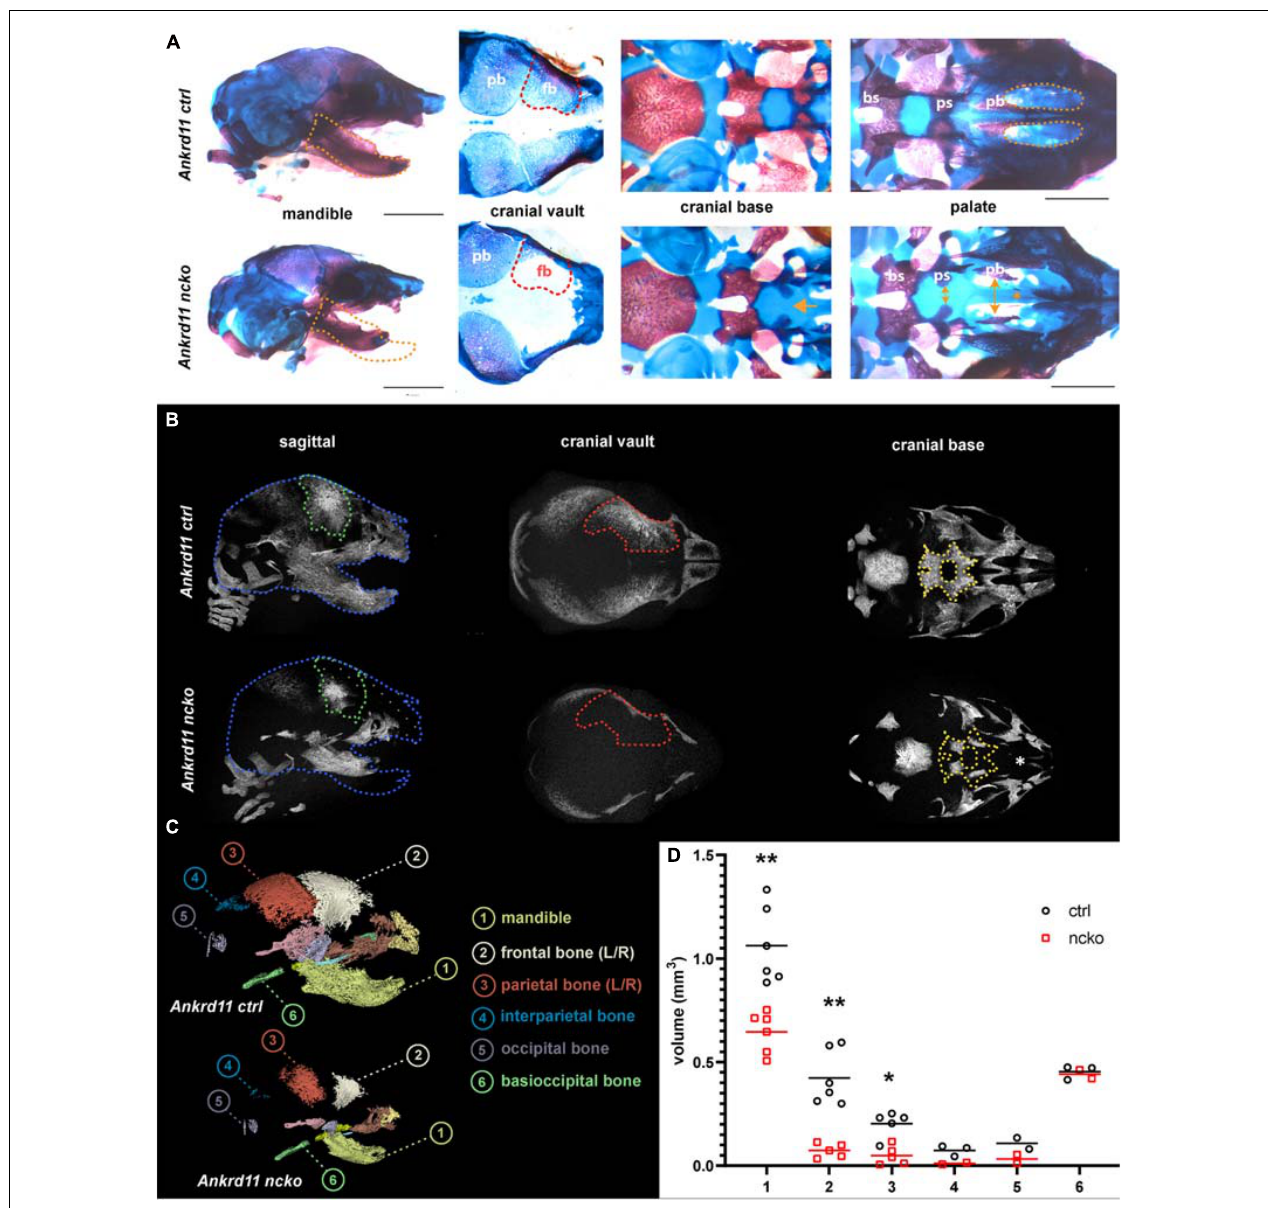
FIGURE 2 | Ankrd11 ncko mice have compromised ossification in craniofacial structures at birth. (A) Wholemount images of postnatal day 0 (P0) skull skeletal preparations, stained with Alizarin red and Alcian blue. Left panels: Orange dotted lines outline Ankrd11 ctrl (Ankrd11 fl / fl ) mandible to indicate micrognathia in the mutant. Middle left panels: Red dotted lines outline Ankrd11 ctrl (Ankrd11 fl / fl ) frontal bone to indicate its smaller size in the mutant. Middle right panels: Yellow arrows indicate extra space between presphenoid and palatine bones of the cranial base. Yellow asterisk to the right highlights clefting of hard palate in Ankrd11 ncko mouse. Right panels: magnified view of palate. bs, basisphenoid bone; ps, presphenoid bone; pb, palatine bone. Scale bar represents 2 mm, third column represents 1 mm. (B) µ CT scans of P0 Ankrd11 ncko and Ankrd11 ctrl skulls reconstructed in Amira. Blue dotted lines: Ankrd11 ctrl skull outline. Green dotted lines: control frontal bone outline. Tan dotted fill in Ankrd11 ncko : negative space between control mouse and mutant. Red dotted lines: control frontal bone outline. Yellow dotted lines: control basisphenoid and presphenoid hard tissue outline. White asterisk indicates reduction in palatine bone ossification in the mutant mouse. (C) representative segmentation of individual bones from µ CT scans of P0 Ankrd11 ncko and Ankrd11 ctrl skulls. (D) Quantification of segmented bone volumes (mm 3 ) from Ankrd11 ncko and Ankrd11 ctrl pups (independent two-sample t -test assuming unequal variances, ** p < 0.001, * p < 0.05, n = 6). Segmentation and volume analysis performed using 3D Slicer.